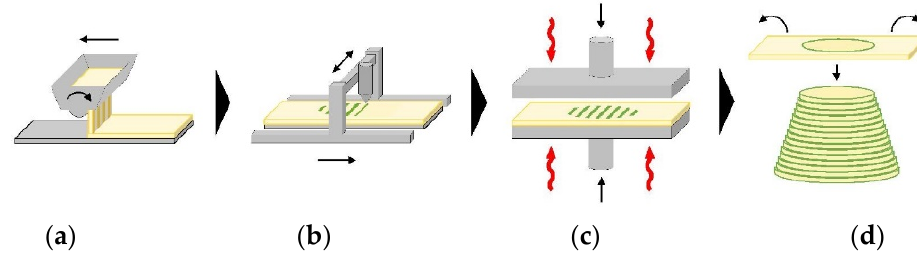
Figure 5. Principle of ILF fabrication [46]. Particles are spread in a thin layer by a scattering device ( a ), a liquid adhesive is applied locally, ( b ). The particle adhesive layer is then pressed and heated ( c ), the unbound bulk is removed, and the completed panel is transferred and laminated onto the stack of the previously fabricated panels ( d ).